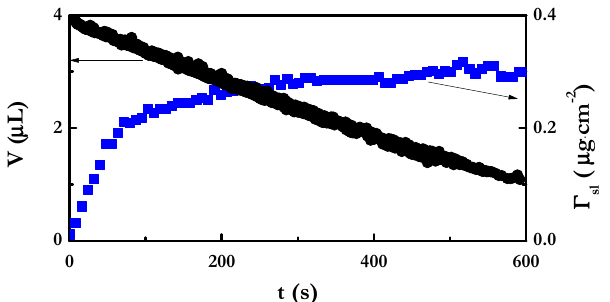
Figure 7. Time dependences of the volume of an evaporating sessile droplet at a relative humidity of 60% on a silicon wafer and of the surface excess at the solid/liquid interface, as was obtained using a quartz crystal microbalance with dissipation monitoring (QCM-D) for a PDADMAC–SLES mixture ((SLES) = 2.62 µM ), with the PDADMAC concentration being 5 g/L.